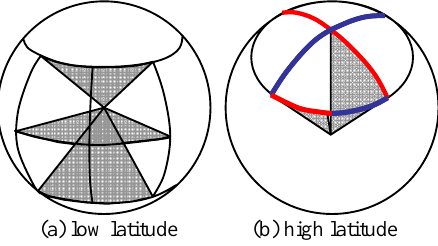
Figure 5. The partition curve surface corresponding to b -curve